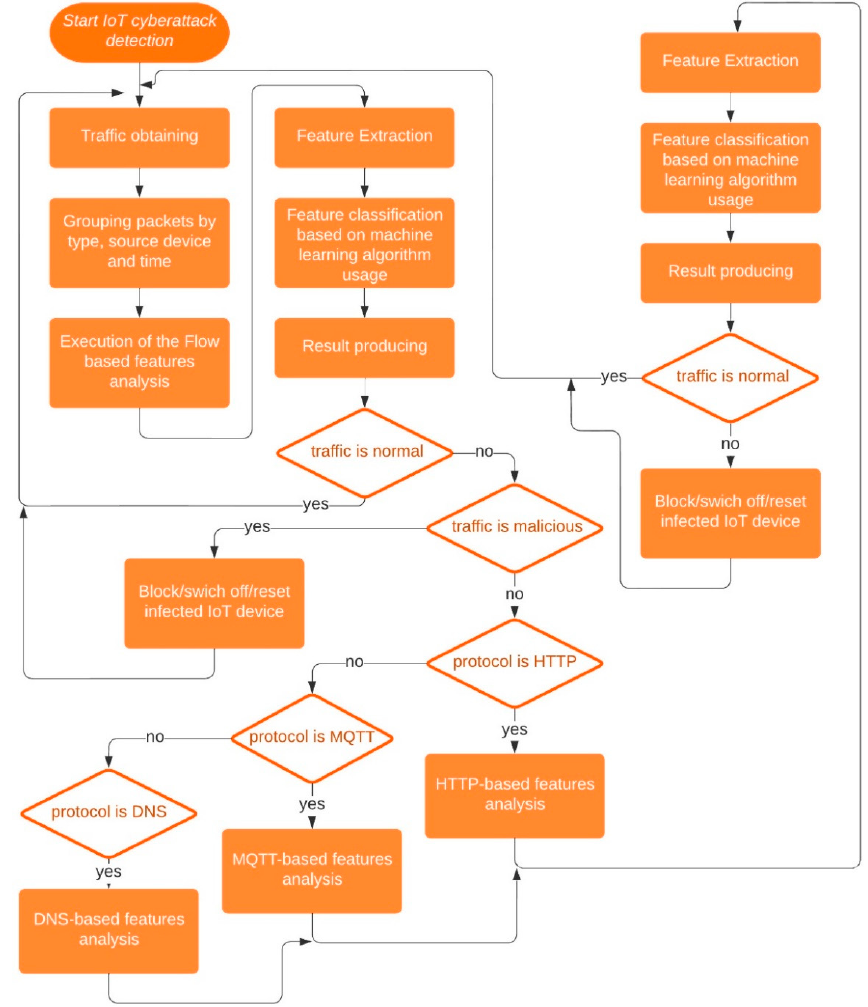
Figure 1. IoT cyberattack detection scheme.